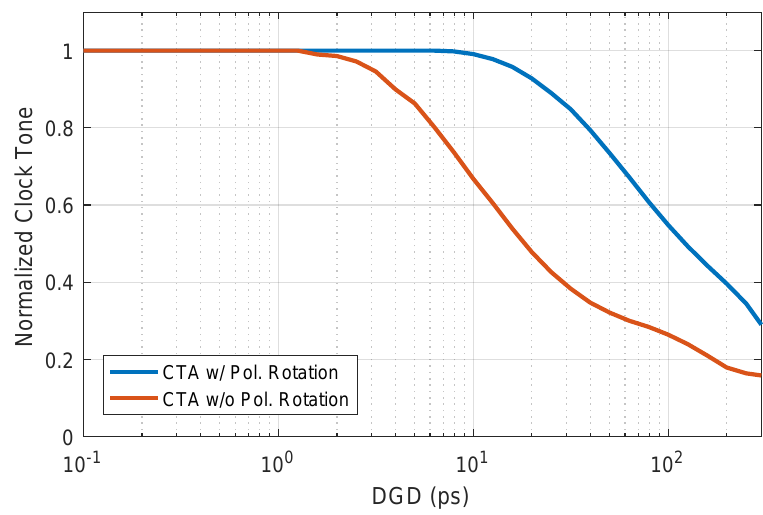
Figure 6. Normalized clock tone amplitude as function of resulting DGD for a single-mode fiber.